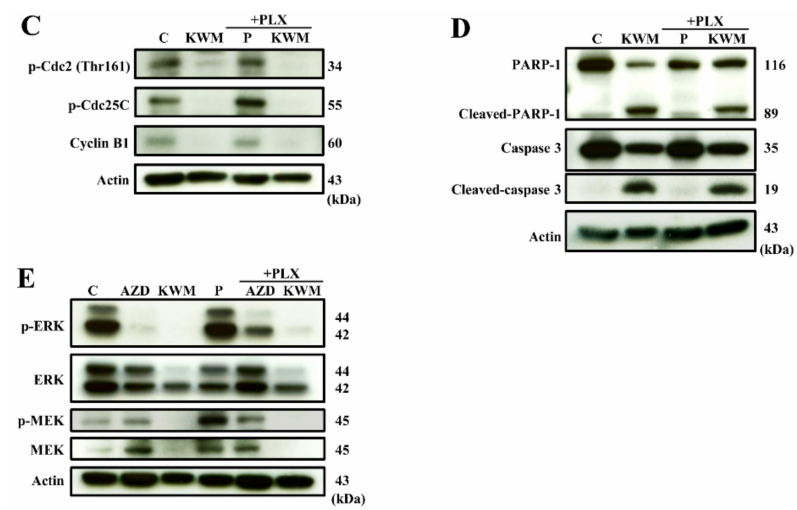
Figure 2. E ff ect of KWM-EO on cell-cycle and apoptosis in PDV cells. ( A ) PDV cells were exposed to vehicle or 75 µ g / mL KWM-EO in the presence or absence of 0.5 µ M PLX4032 for 12 or 24 h, then the cell-cycle was analyzed by flow cytometry. ( B ) PDV cells were treated with vehicle or 75 µ g / mL KWM-EO in the presence or absence of 0.5 µ M PLX4032 for 24 h. Cells were then stained with annexin V and propidium iodide, and the cell apoptosis was detected by flow cytometry. ( C ) PDV cells were treated with 75 µ g / mL KWM-EO in the presence or absence of 0.5 µ M PLX4032 for 24 h before lysis. The cell lysates were subjected to Western blotting against cell-cycle-related proteins, including p-cdc2 (Thr161), p-cdc25C, and cyclin B1. ( D ) The expression level of apoptosis-related proteins in PDV cells treated with 75 µ g / mL KWM-EO in the presence or absence of 0.5 µ M PLX4032 for 6 h was examined by Western blotting against PARP-1 and caspase 3. ( E ) Western blotting analysis of MAPK signaling-related proteins (p-ERK, ERK, p-MEK, MEK) in PDV cells treated with 75 µ g / mL KWM-EO in the